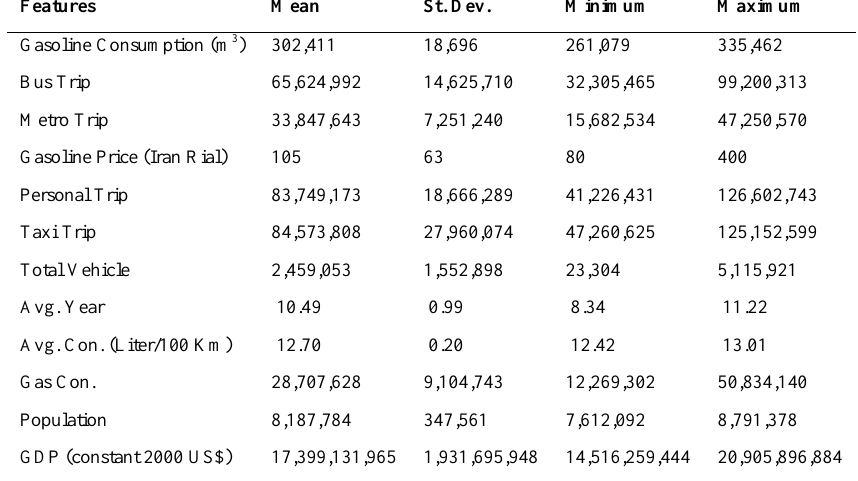
Table 2 . Basic statistics for features.